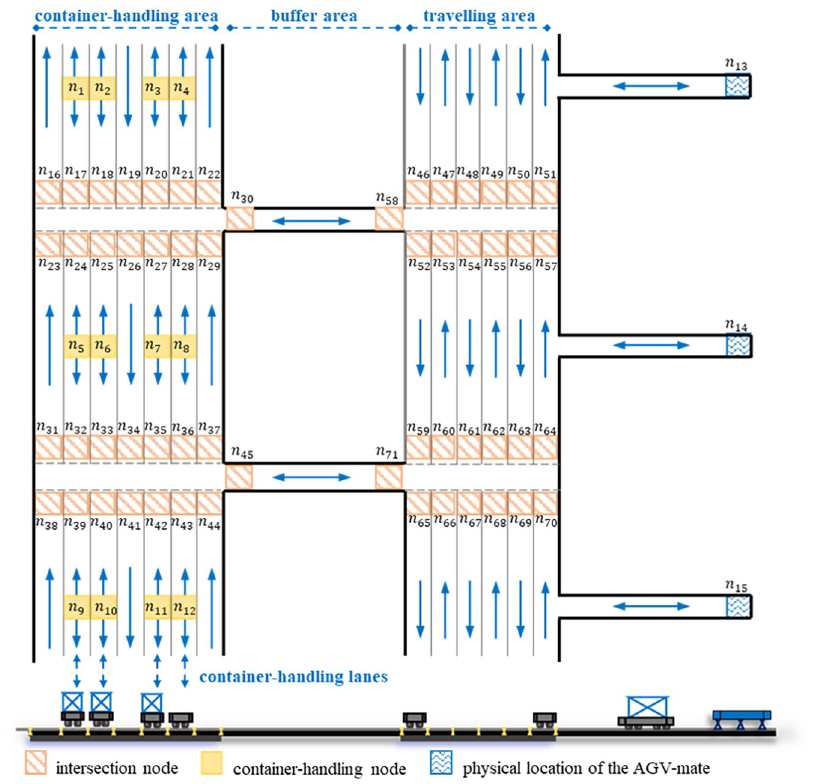
Fig 2. The layout of the multi-lane AGV road